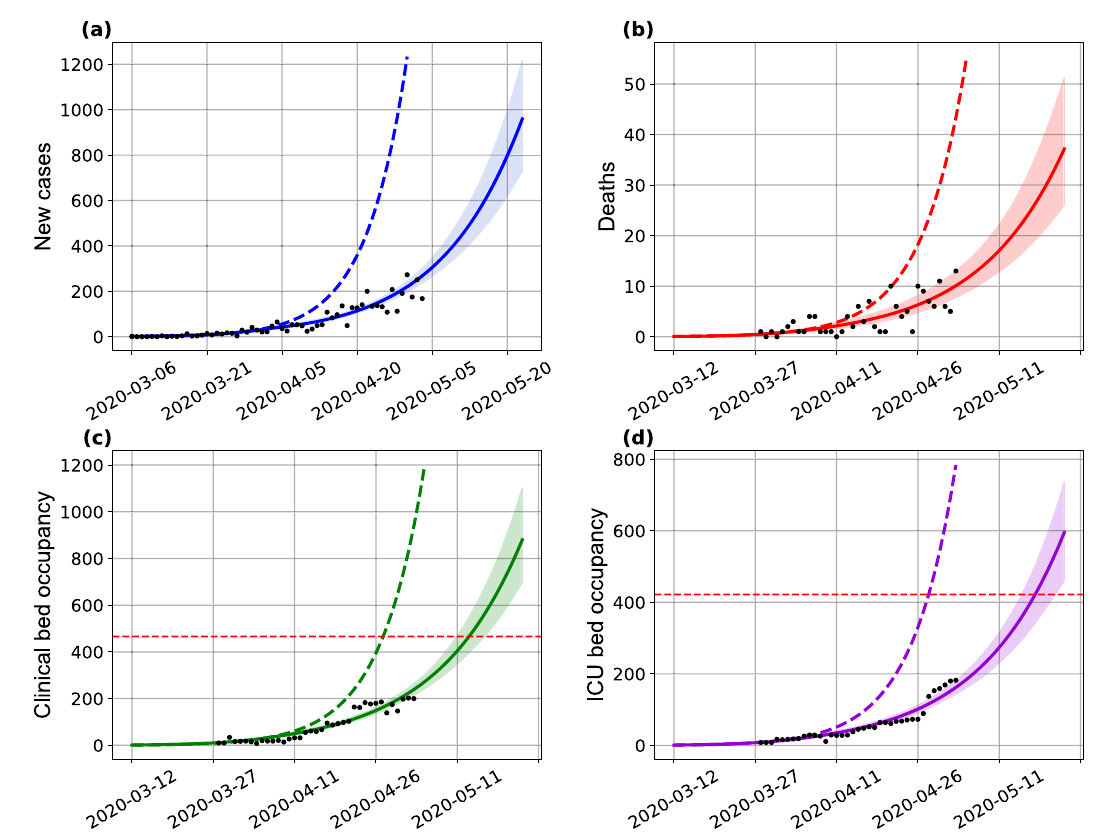
Fig. 3 Effects of the implemented interventions in Bahia. Effects on the number of ( a ) cases, ( b ) deaths, ( c ) clinical hospitalization, and ( d ) ICU bed requirements at the state level. The horizontal red dashed lines are, respectively, the current capacity for beds for clinical hospitalization (466 beds) and ICUs (422 beds). The blue dashed and full lines represent the evolution of the epidemic with a fi xed transmission rate β 0 and with both β 0 and β 1 , respectively. The shaded error bands represent 95% con fi dence intervals of the mean calculated using the weighted non-parametric bootstrap method. Residual analysis to visualize a tendency between the data and simulations are presented in Supplementary Fig. 7. The assumed parameter values are shown in Supplementary Table 3. Raw data from March 6 to May 4, 2020 are shown in this